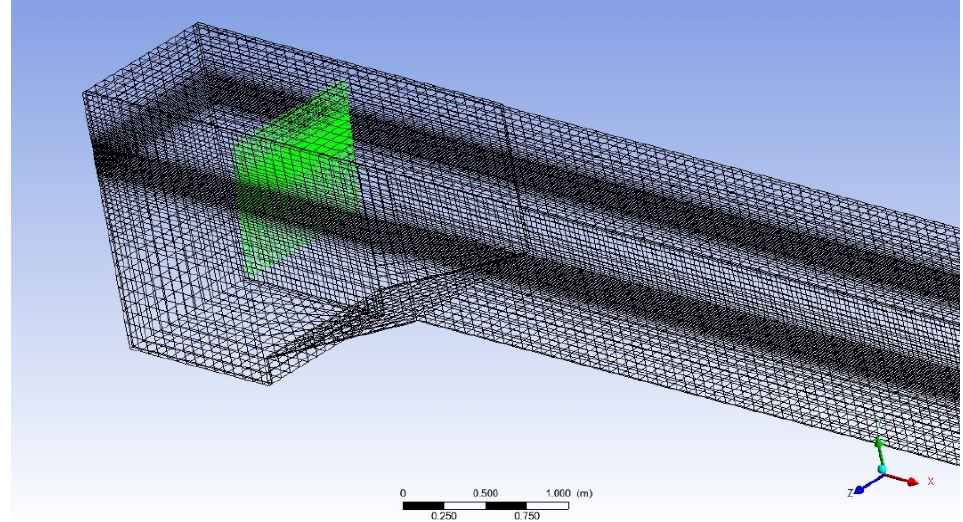
Figure 8. A sample mesh of the three-dimensional numerical wave tank.